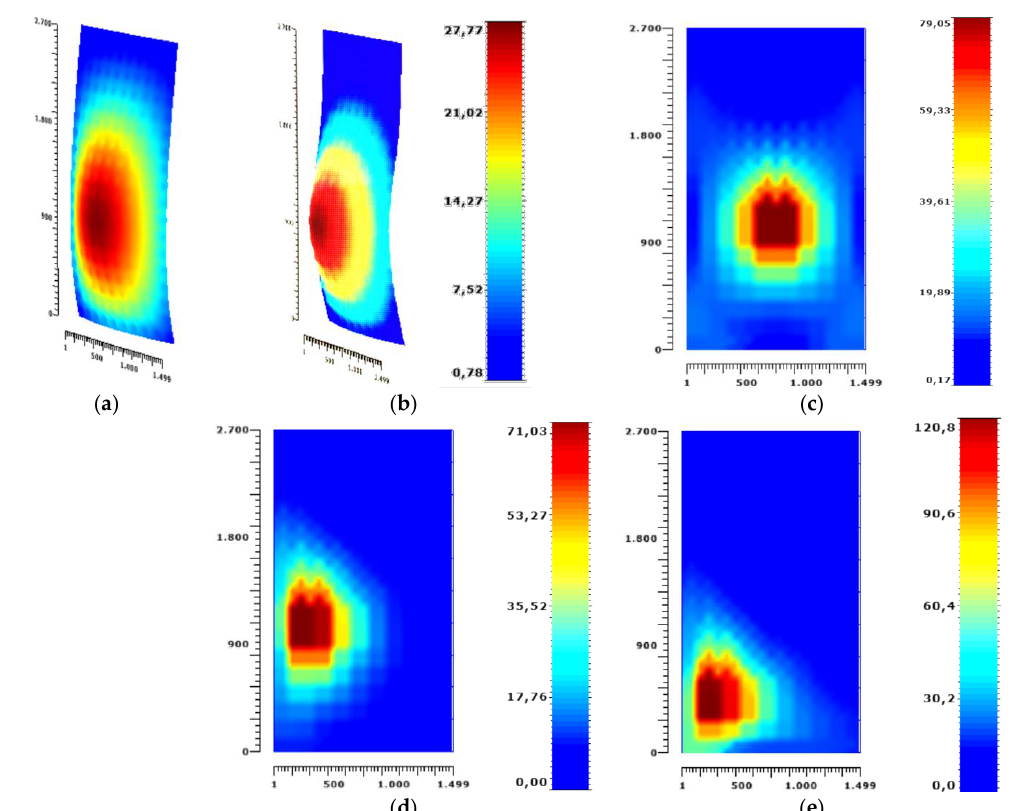
Figure 14. Typical deformed shape of the examined curtain wall (Code Aster): ( a ) fundamental modal shape (frequency analysis) and ( b – e ) example of impact responses (legend values in mm and MPa). ( a ) T 1 = 0.1 s. ( b ) Displacement (SB, P#1, E imp = 900 J). ( c ) Stress (SB, P#1, E imp = 900 J). ( d ) Stress (SB, P#4, E imp = 450 J). ( e ) Stress (SB, P#5, E imp = 900 J).